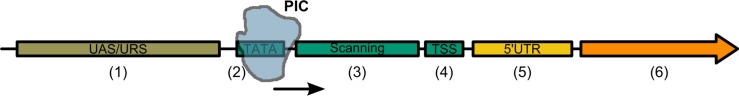
Schematic representation of the structure of a yeast promoter.The yeast promoter is typically divided in upstream activating or repressive sequences (UAS/URS, 1) and the core promoter region (2, 3 and 4). The pre-initiation complex (PIC) containing RNA polymerase II is recruited to the TATA box or a TATA-like sequence (2) and scans (3) the core promoter to a suitable transcription start site (TSS, 4). Other depicted elements are the 5’ untranslated region (5’UTR, 5) and the coding sequence (6).